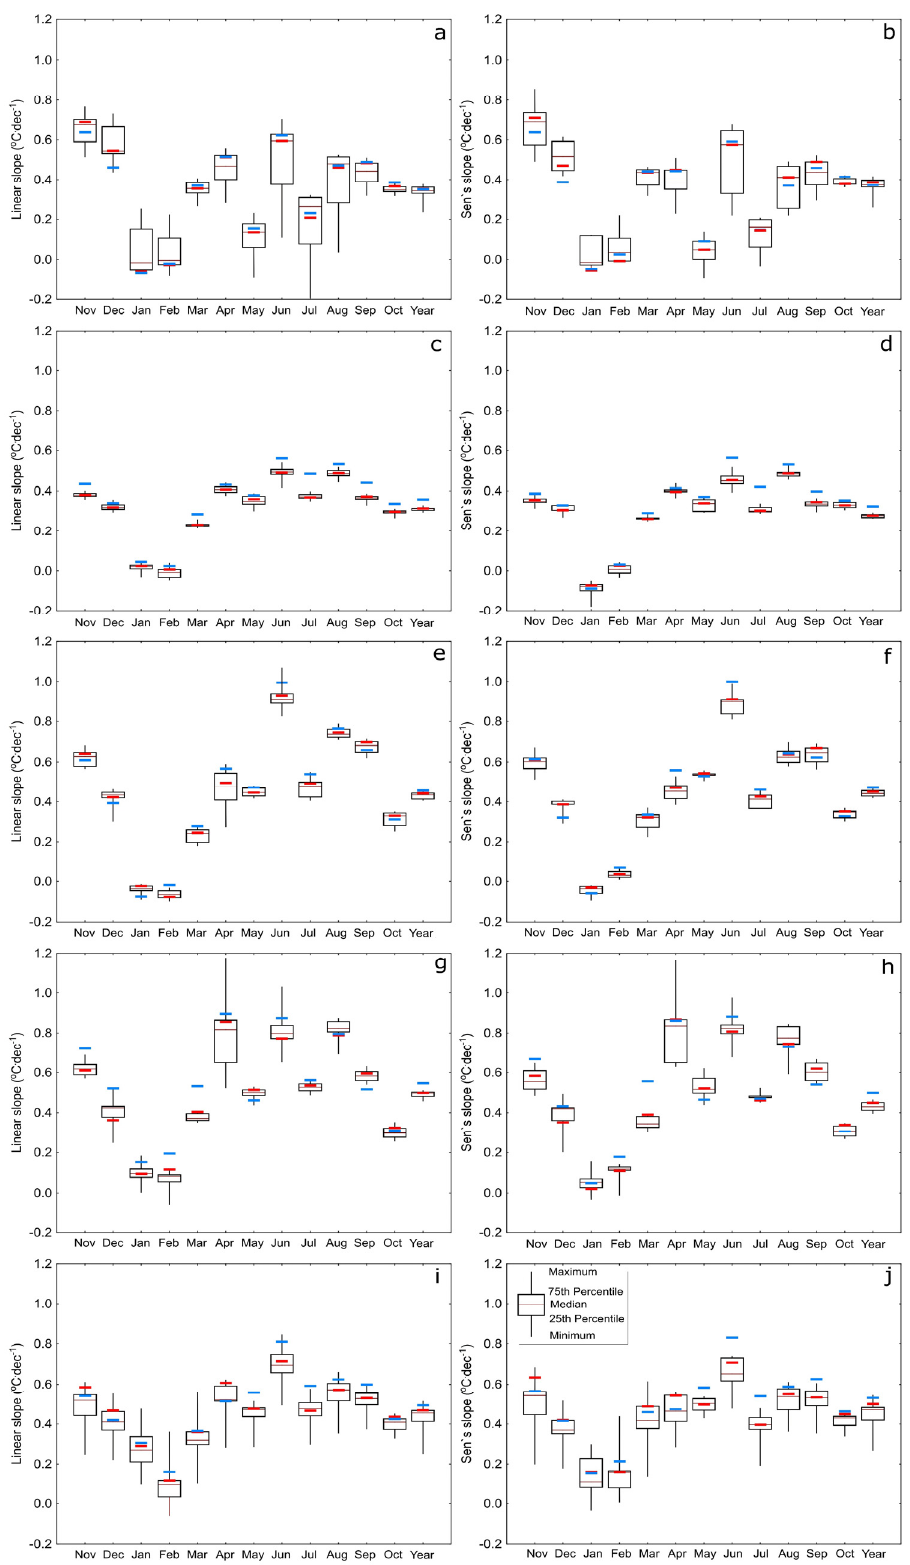
Figure 5. Linear slope ( a , c , e , g , i ) and Sen slope ( b , d , f , h , j ) values based on data reconstructed by means of multilayer perceptrone network models in the context of values obtained based on measurement data (blue line) and values obtained from the best multilayer perceptrone network/g model (red line) for rivers: Drw ę ca ( a , b ), Ł eba ( c , d ), Ł yna ( e , f ), Pisa ( g , h ) and Wda ( i , j ).